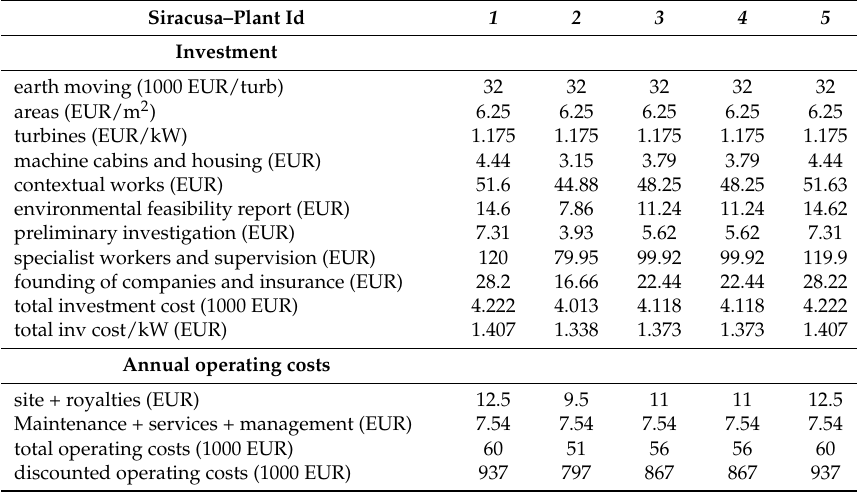
Table 2. Elements of the cost/revenue analysis applied to the wind farm investments—five of the nine plants considered in the province of Siracusa (our